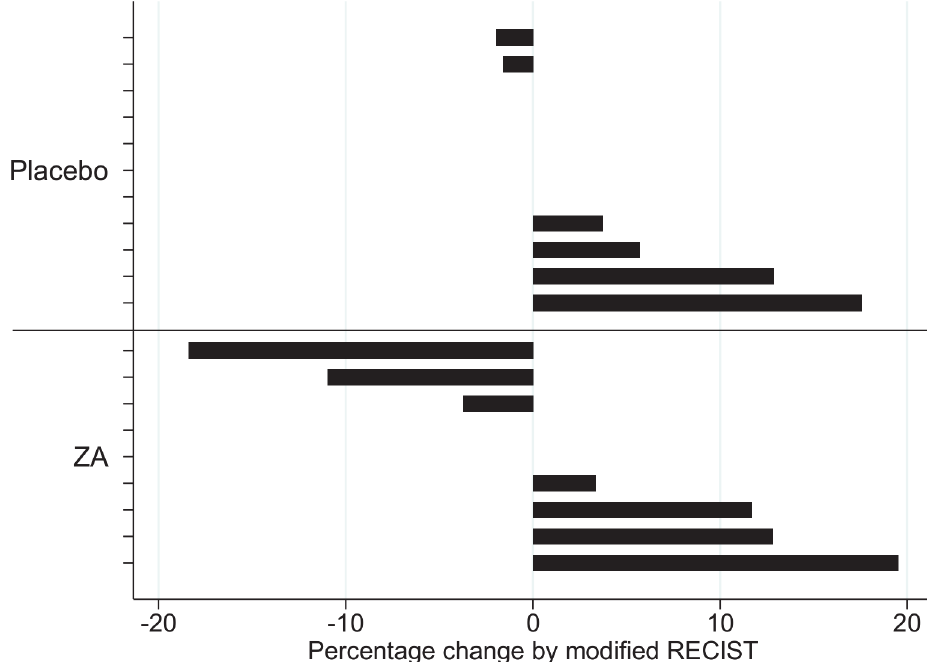
Fig 4. % Change in modified RECIST scores from baseline to week